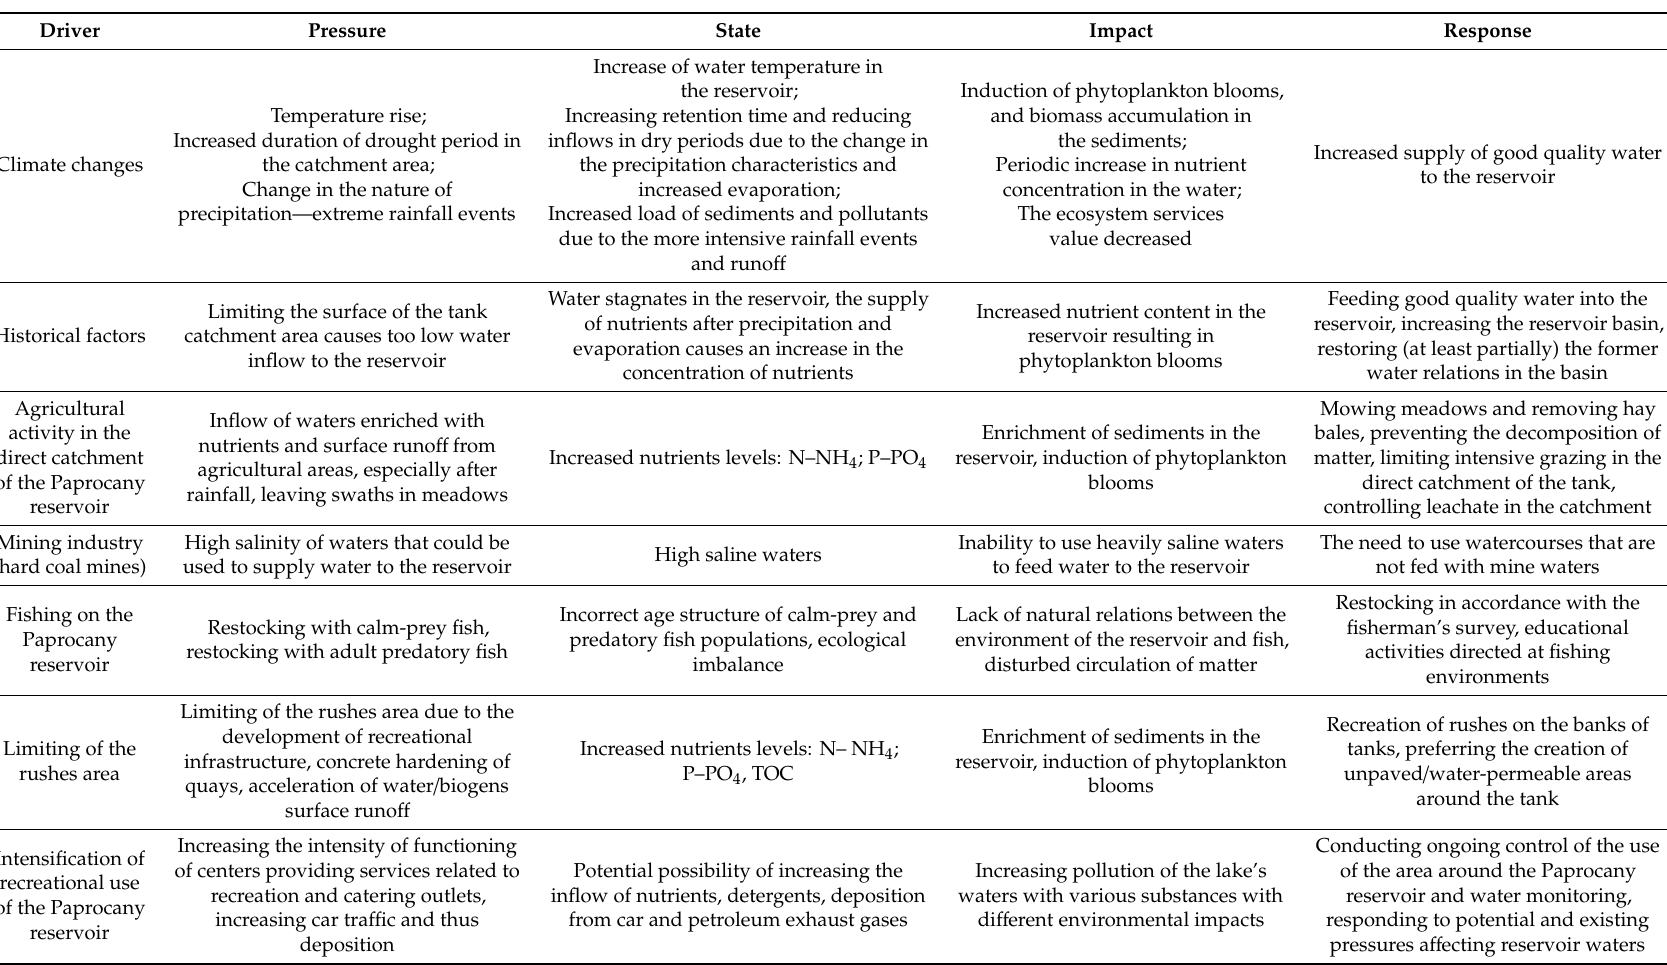
Table 9. DPSIR analysis of the Paprocany